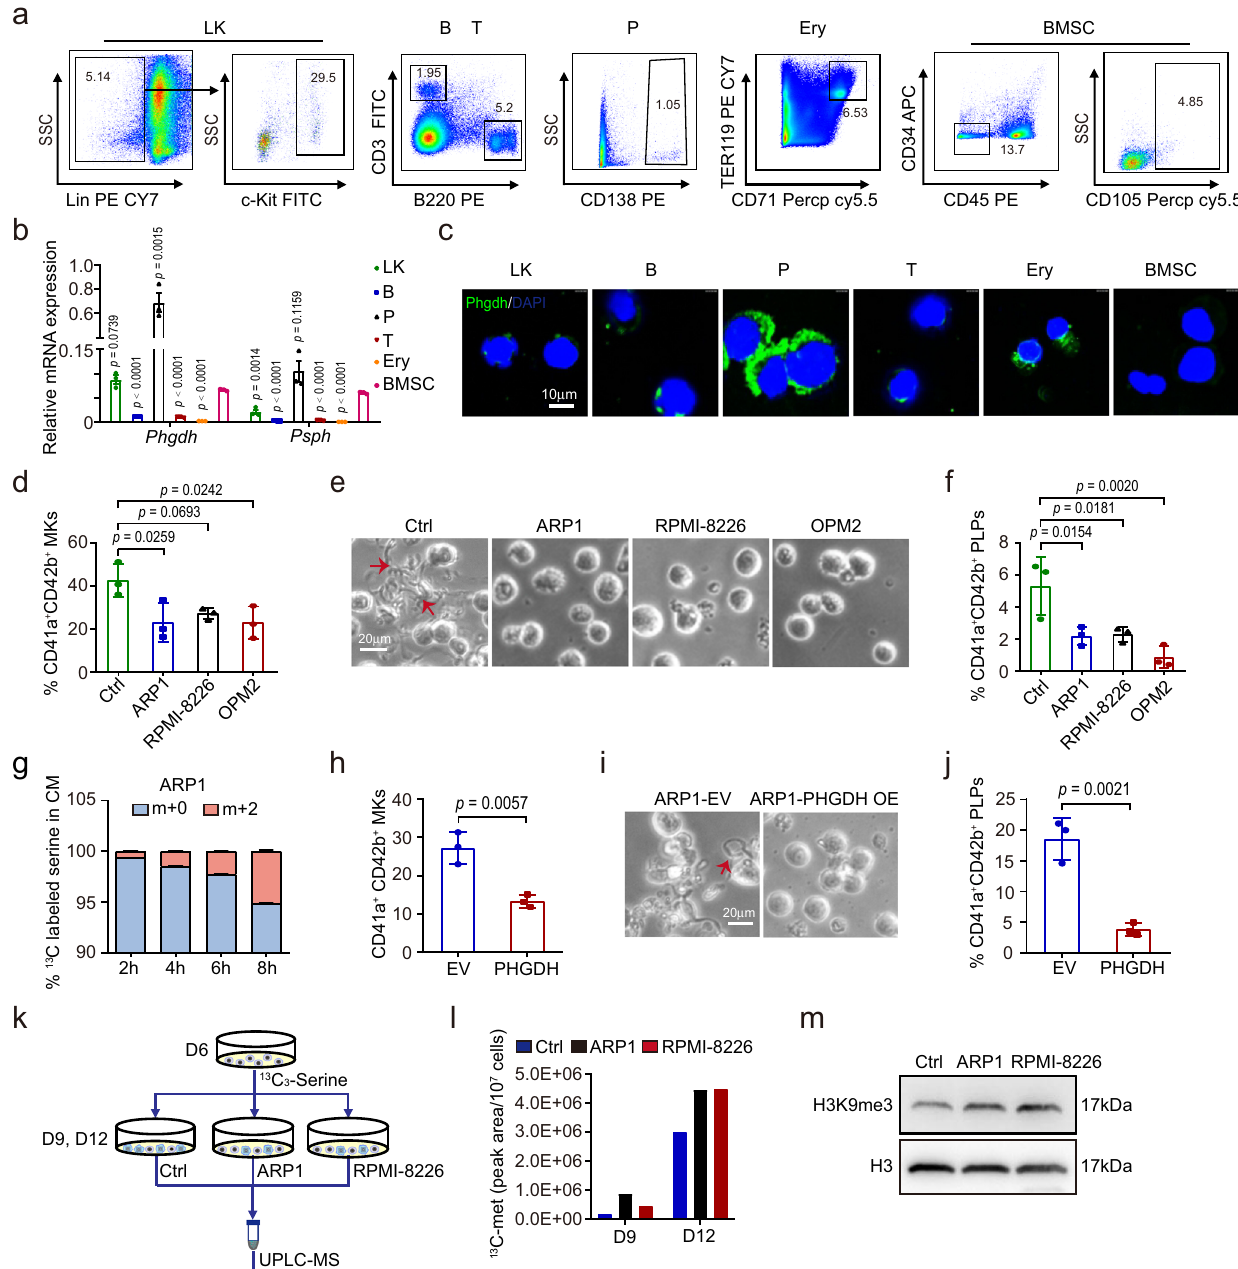
Fig. 6 | Serine accumulated in the BM microenvironment is released from myeloma cells. a , b Representative plots for the isolation of and relative mRNA levels of Phgdh and Psph were detected in LK, B cell, plasma cells, T cell, ery- throcytes, and BMSCs from the BMME of 5TGM1 mice (mean±SD, n =3 indepen- dent experiments). c Representative images of immuno fl uorescence stained with Phgdh in different cells. The scale bar is 10 µ m. d Flow cytometry analysis of the percentage of CD41a + CD42b + cells at day 12 of megakaryocytic differentiation treated with or without the CM from MM cells (mean±SD, n =3 independent experiments). e , f Phase-contrast images of proplatelet formation and generation of CD41a + CD42b + PLPs at day 12 from CD34 + cells treated with or without the CM fromMMcells(mean±SD, n =3independentexperiments).Thescalebaris20 µ m. g 13 C-labeled serine inthe CM from ARP1 cellstreated with 13 C 2 glycine (mean±SD, n =3 independent experiments). h Flow cytometry analysis of the percentage of